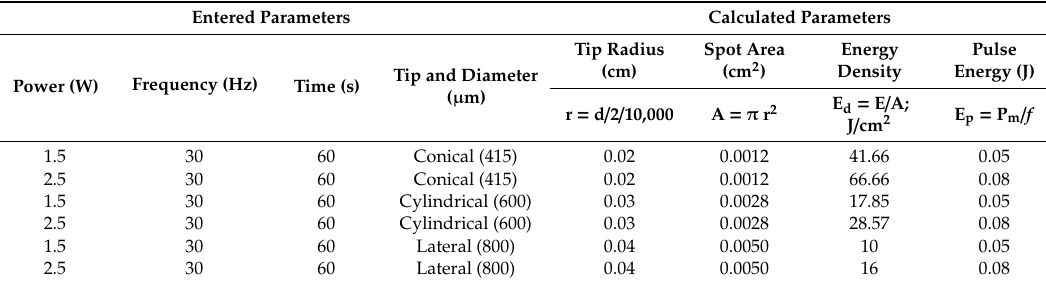
Table 1. Dosimetry of the Er,Cr:YSGG Laser. W: Watts; Hz: Hertz; sec: seconds; µ m: micrometers; cm: centimeters; r: radius; d: diameter; A: Area; E d : Energy density; J: Joules; E p : Pulse energy; P m : Mean power.